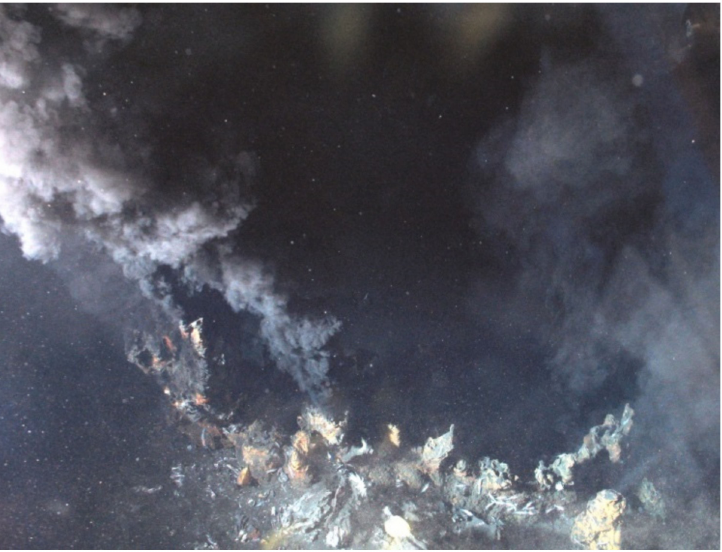
Figure 2. Irina 1 hydrothermal crater. Logachev field (photo taken during the SERPENTINE expedi-